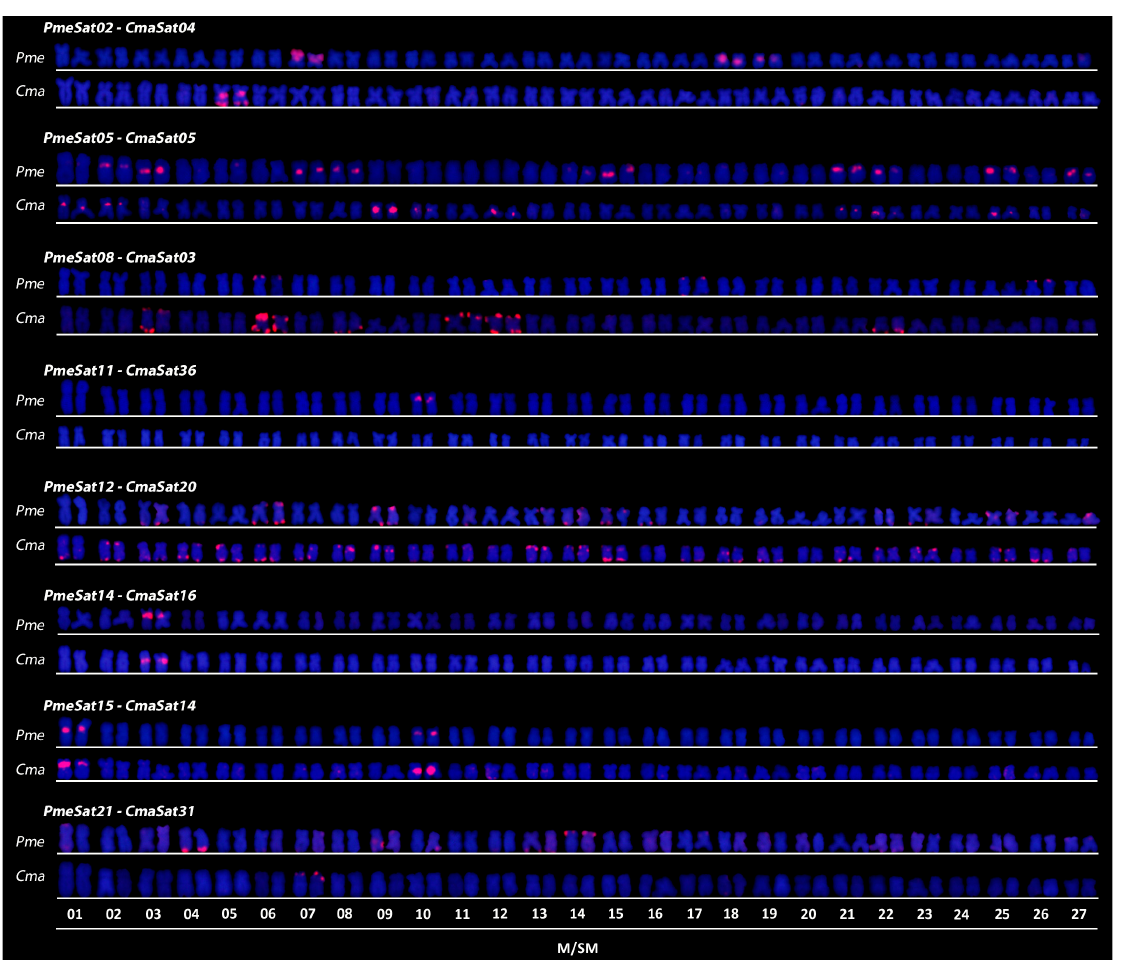
Figure 2. Karyotypes of P. mesopotamicus (Pme) and C. macropomum (Cma) after FISH with shared satDNAs. Table 5. Fish patterns of SatDNA families conserved between P. mesopotamicus and C. macropomum . The patterns of satDNAs were classified as clustered (C), non-clustered (NC) and mixed (M). Posi- tion was catalogued as pericentromeric (c) and telomeric (t).